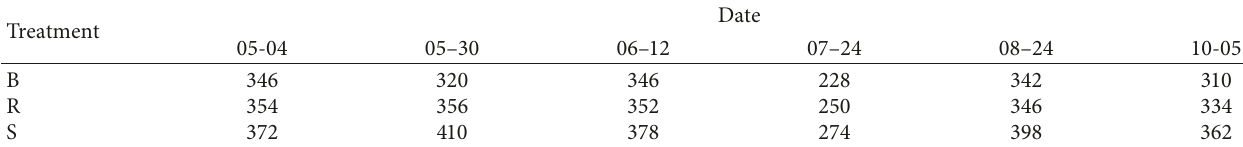
Table 3: Effects of stubble retention methods on soil water storage in different growth periods.